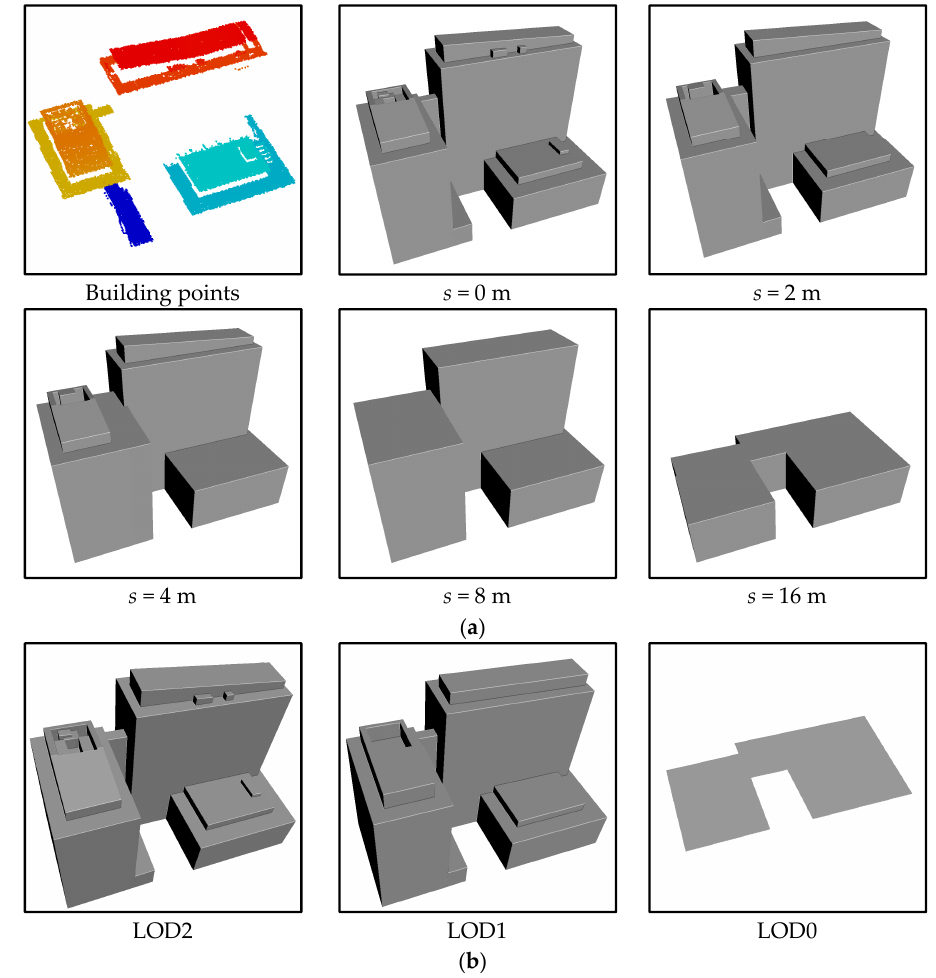
Figure 18. Comparison of LoDs from CityGML and the proposed method for a connected building. ( a ) Building LoDs from the proposed method; ( b ) Building LoDs from CityGML.